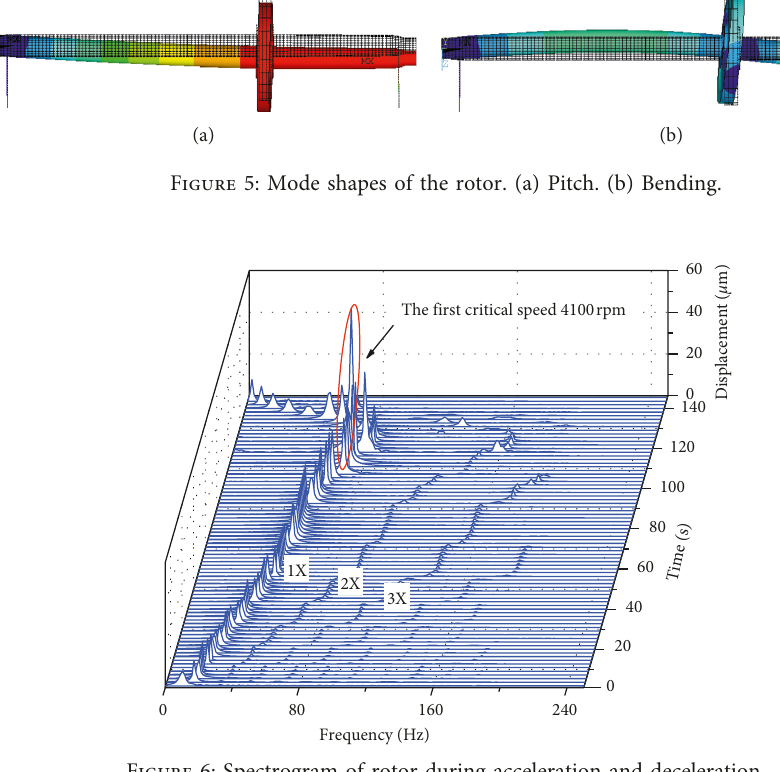
Figure 6: Spectrogram of rotor during acceleration and